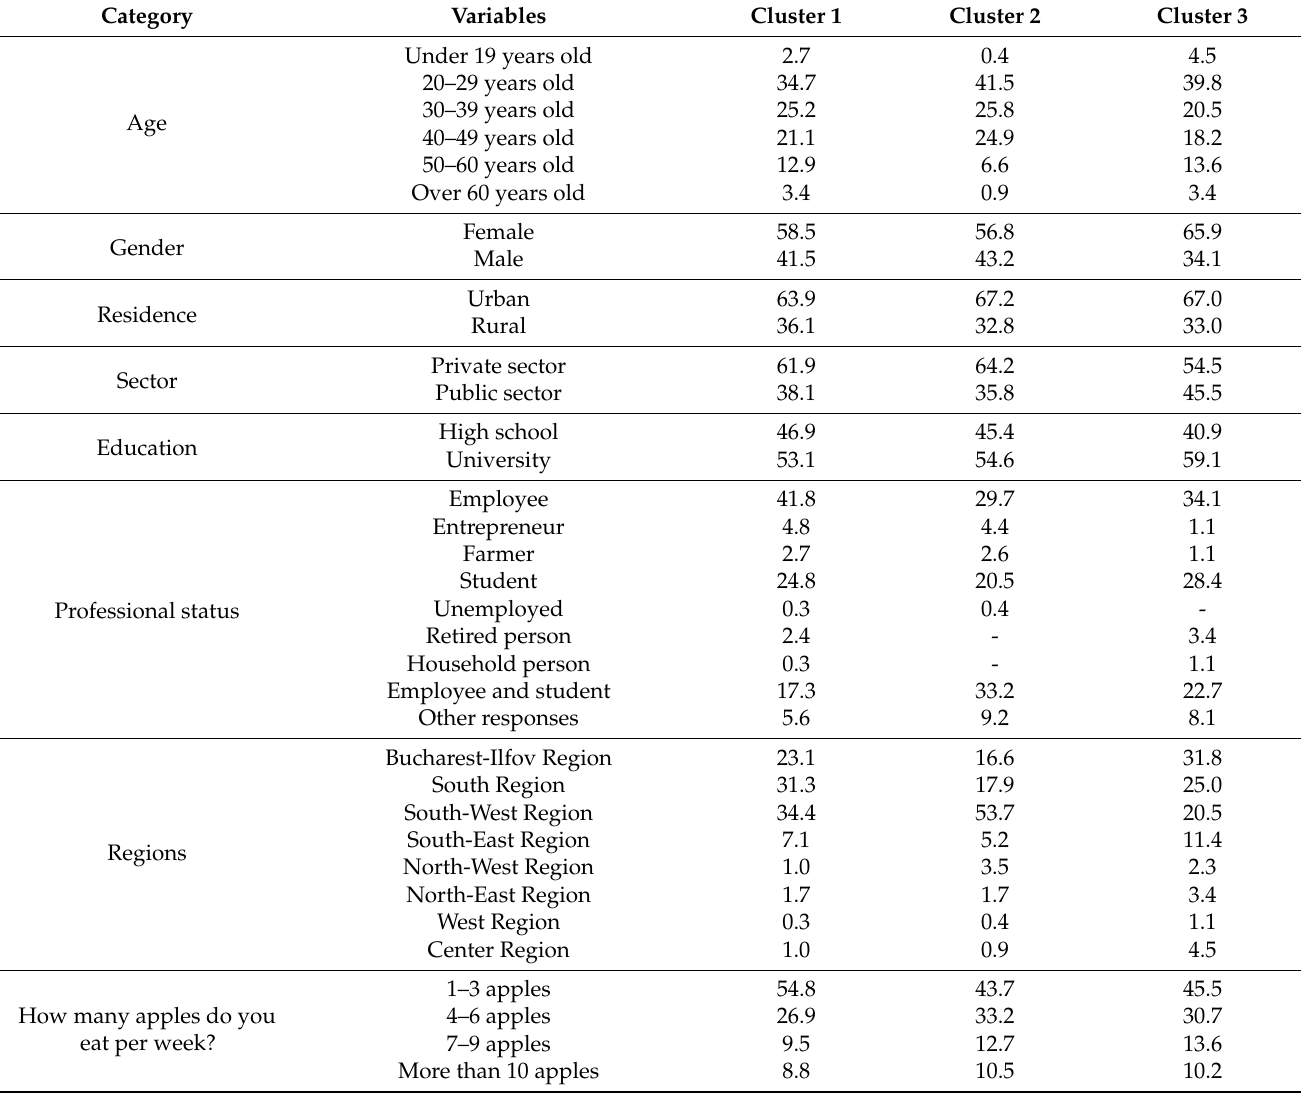
Table 4. Cluster characteristics (frequencies,